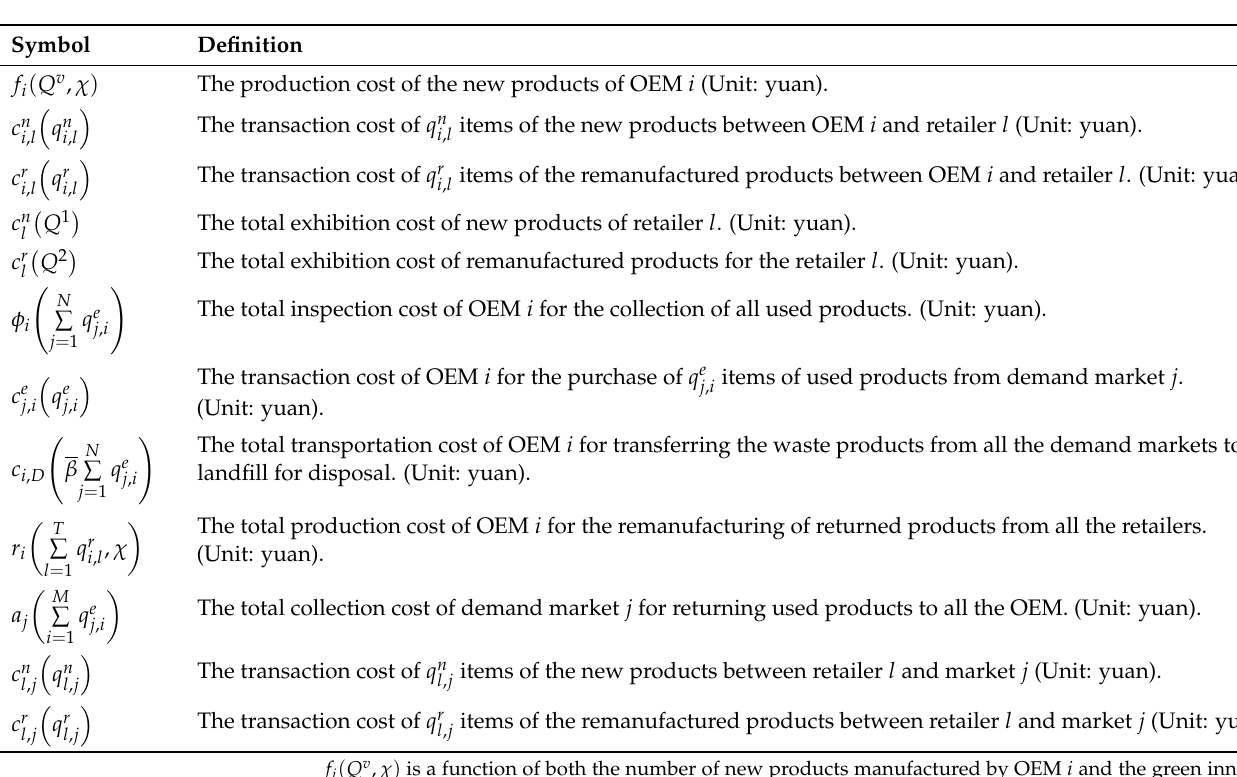
Table 4. The cost functions in the IHRS model.